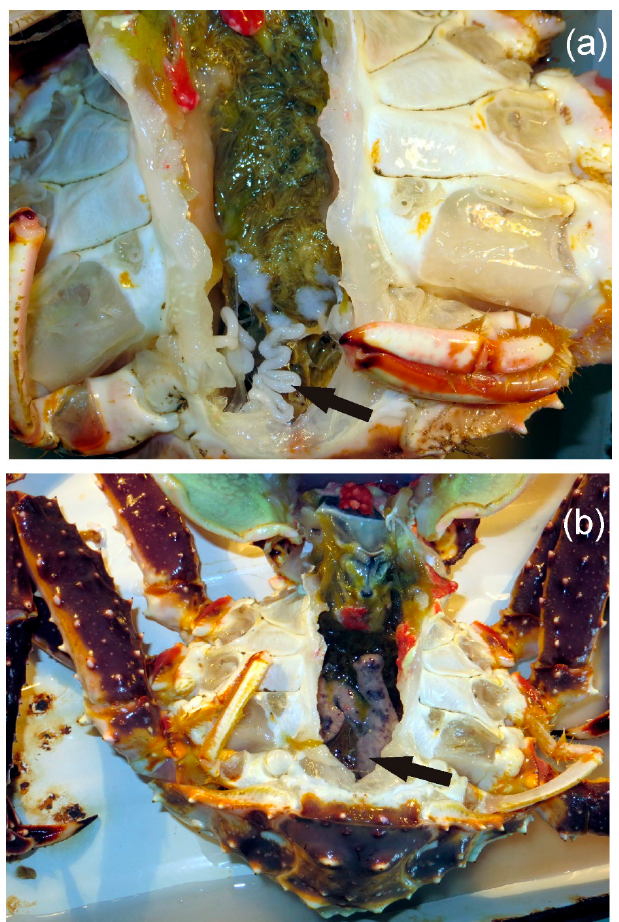
Figure 1. Gonads of male ( a ) and female ( b ) red king crab Paralithodes camtschaticus.